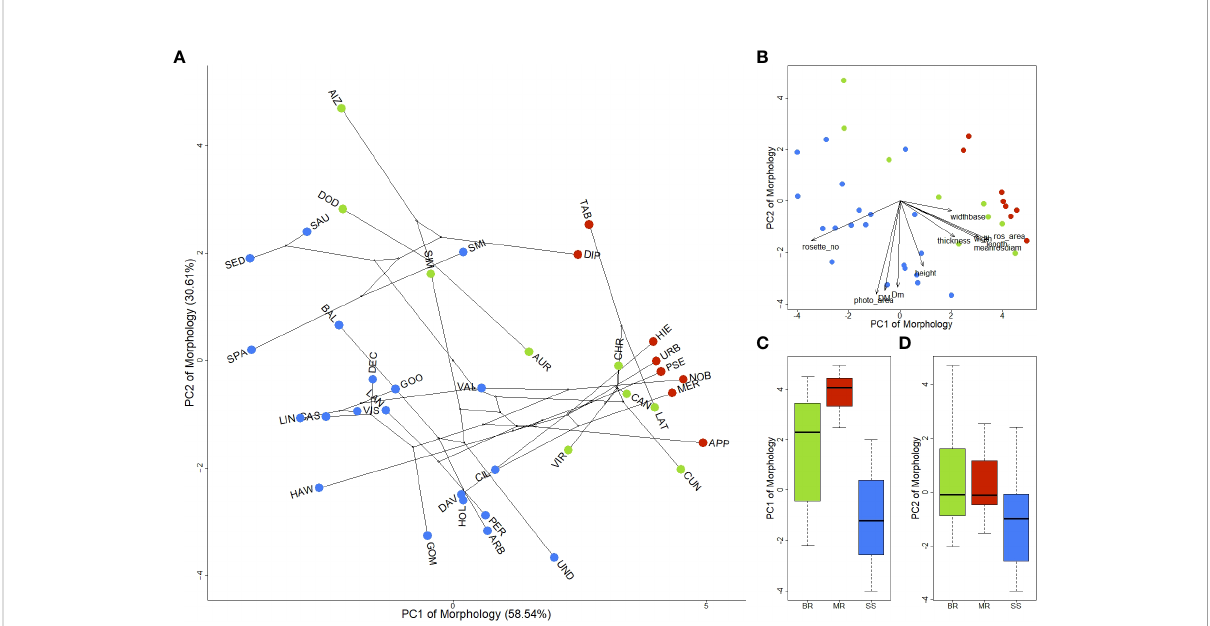
FIGURE 4 Phylogenetic principal component analysis of the morphological space of the Canarian Aeonium . (A) Phylogenetic principal component analysis of the morphological space of Canarian Aeonium . Each dot represents the mean of one taxon (species or subspecies). Lines indicate phylogenetic relationships among species. Taxa are indicated on each dot by a three-letter acronym (see Supplementary Table 1); (B) Loadings of the morphological traits of the phylogenetic principal component analysis (see Supplementary Table 2 for traits ’ abbreviations); (C) Distribution of growth forms along the fi rst axis of the morphological space (PC1); (D) Distribution of growth forms along the second axis of the morphological space (PC2). Colors represent growth forms: green – BR (branching rosettes), red – MR (monocarpic rosettes), blue – SS (Shrubs or subshrubs). PCA loadings in Supplementary Table